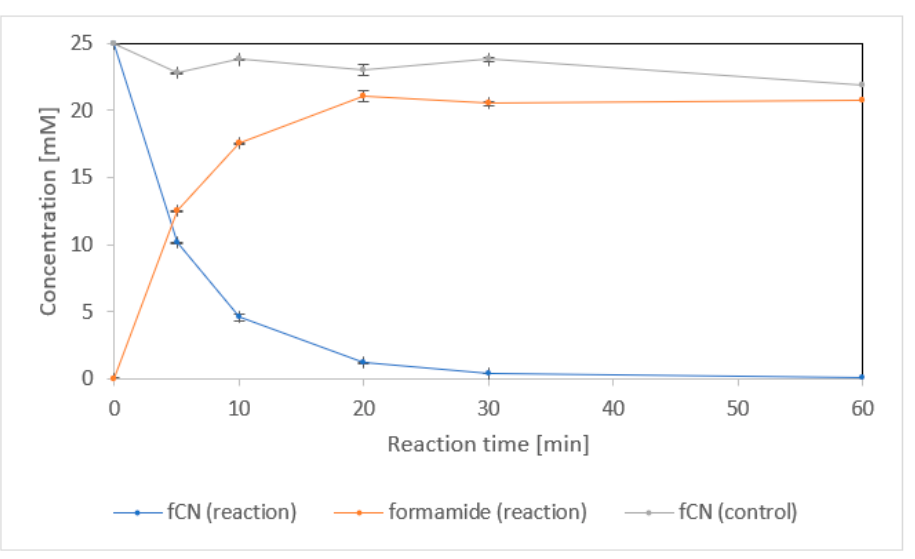
Table 1. Specific activity and kinetic parameters of enzyme